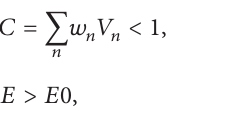
hesitations (Figure 4), the standard deviation of 𝐹1 logarithm – std ( log (𝐹1)) being the additional